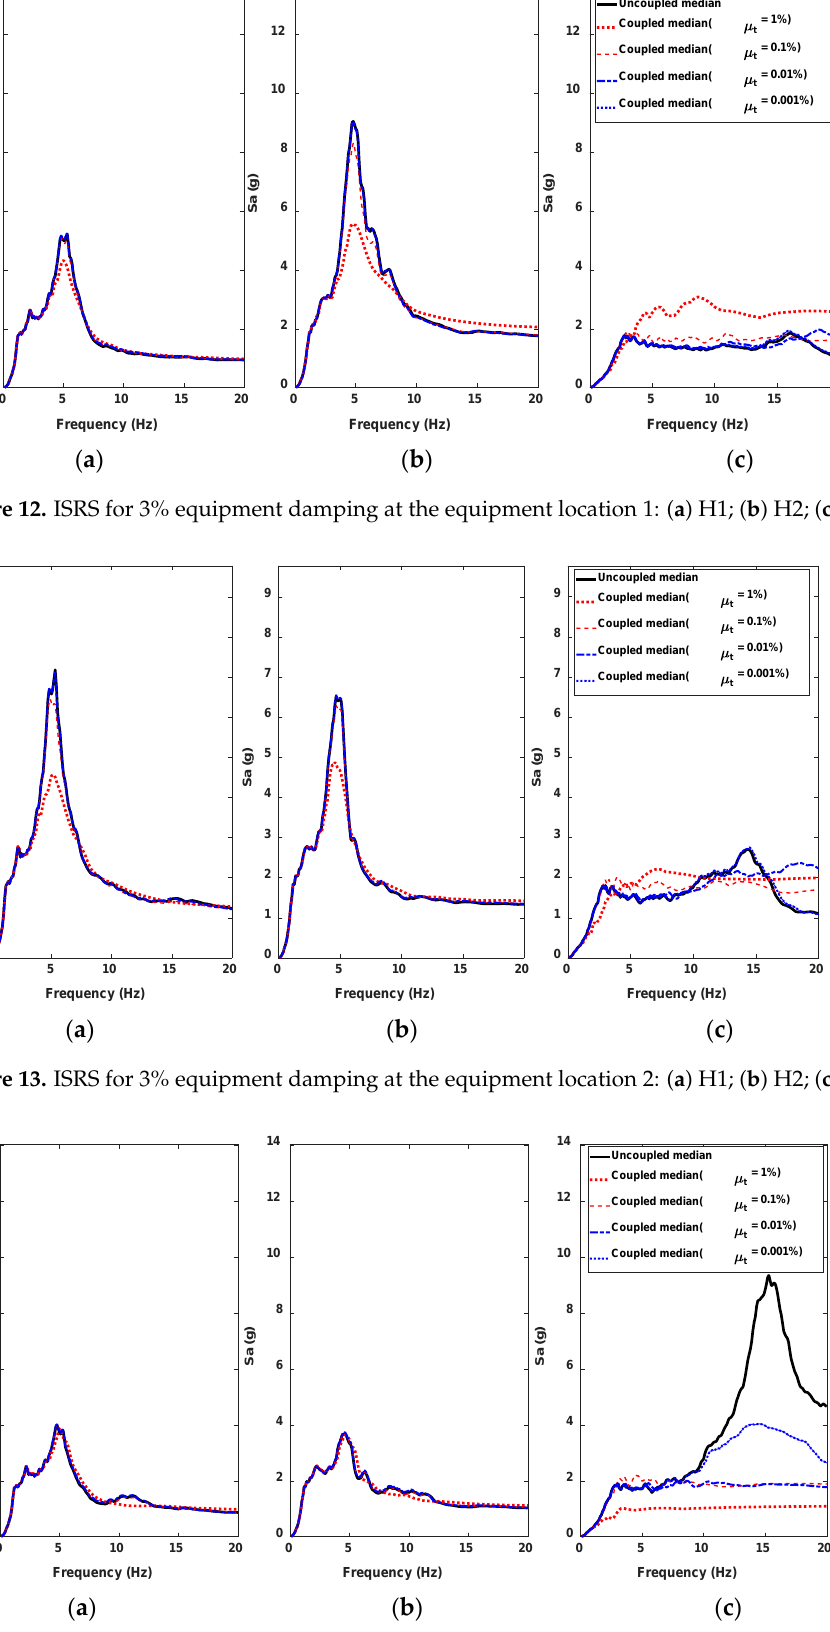
Figure 14. ISRS for 3% equipment damping at the equipment location 3: ( a ) H1; ( b ) H2; ( c )